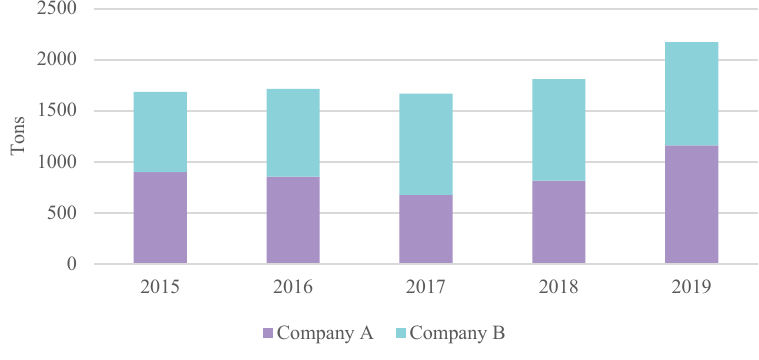
Fig. 3. Total healthcare waste in Latvia